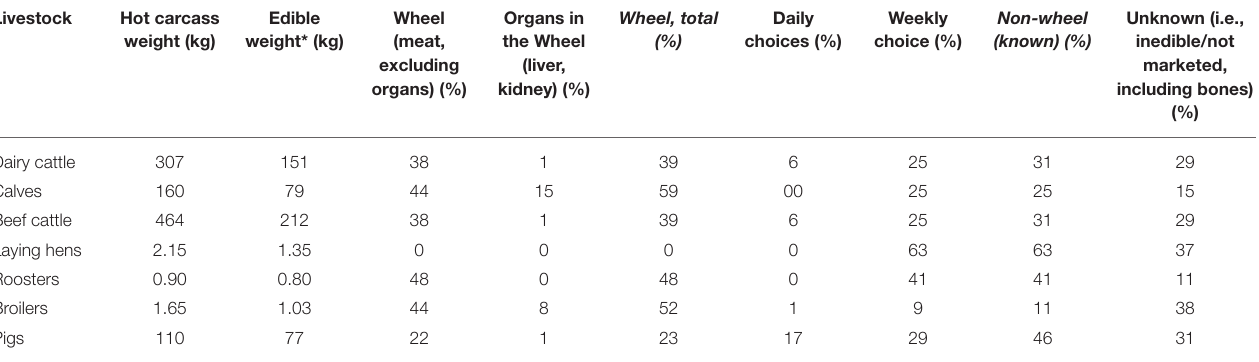
TABLE 1 | Percentage of components within each livestock production system based on